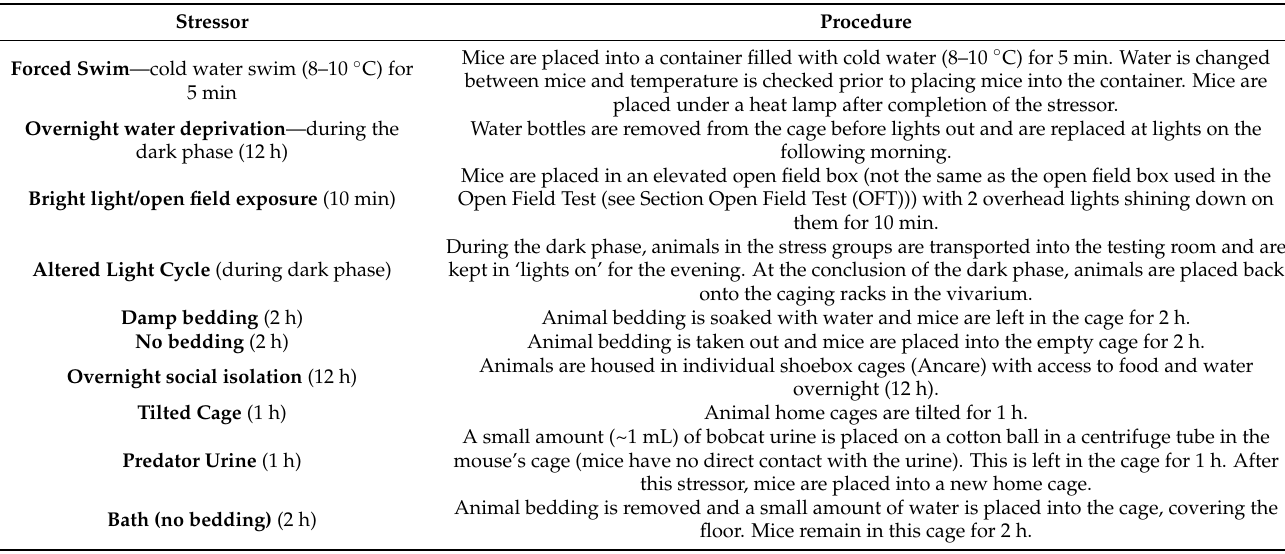
Table 2. List of Stressors and their